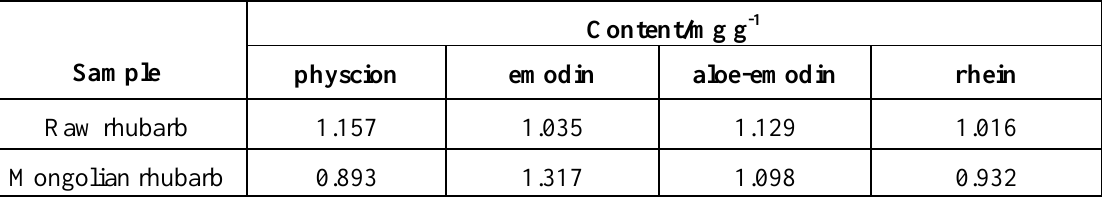
Table 1. Contents of anthraquinone derivatives in Rhubarb